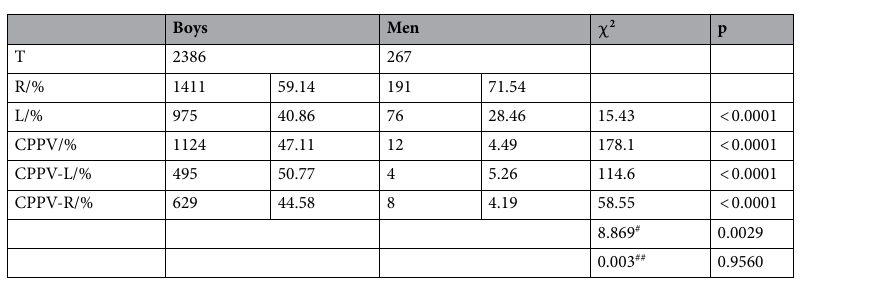
Table 2. Clinical details of unilateral IH in boys and men included in the study. CPPV‑R CPPV of right-sided IH, CPPV‑L CPPV of left-sided IH, # CPPV-R vs. CPPV-L in boys, ## T (theoretical frequency) = 3.42 < 5, Chi- square test with Yates’ correction, CPPV-R vs. CPPV-L in